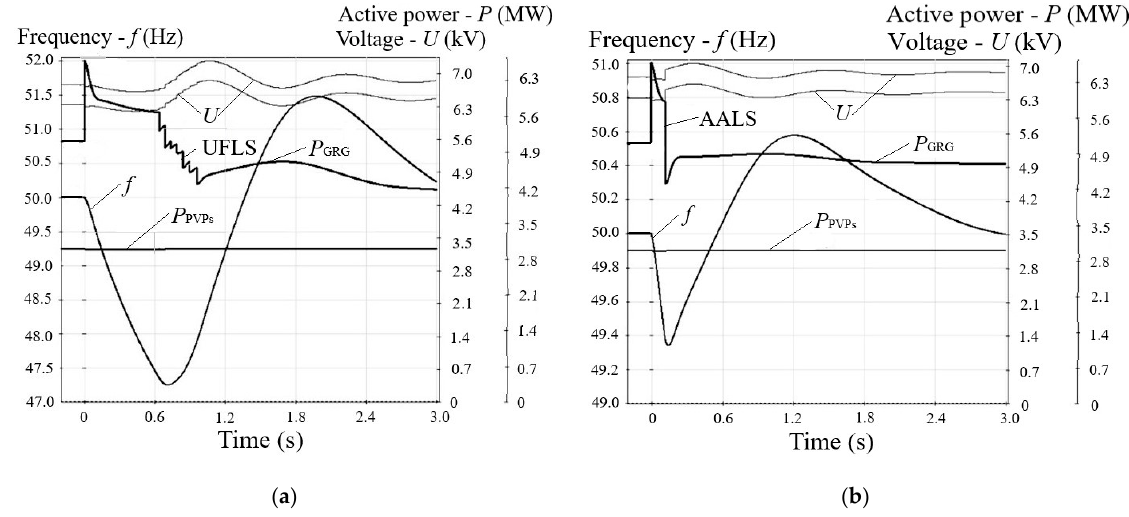
Figure 1. Transient processes: ( a ) a disconnection of three gas-reciprocating gensets and operation of UFLS; ( b ) a disconnection of three gas-reciprocating gensets and operation of AALS.